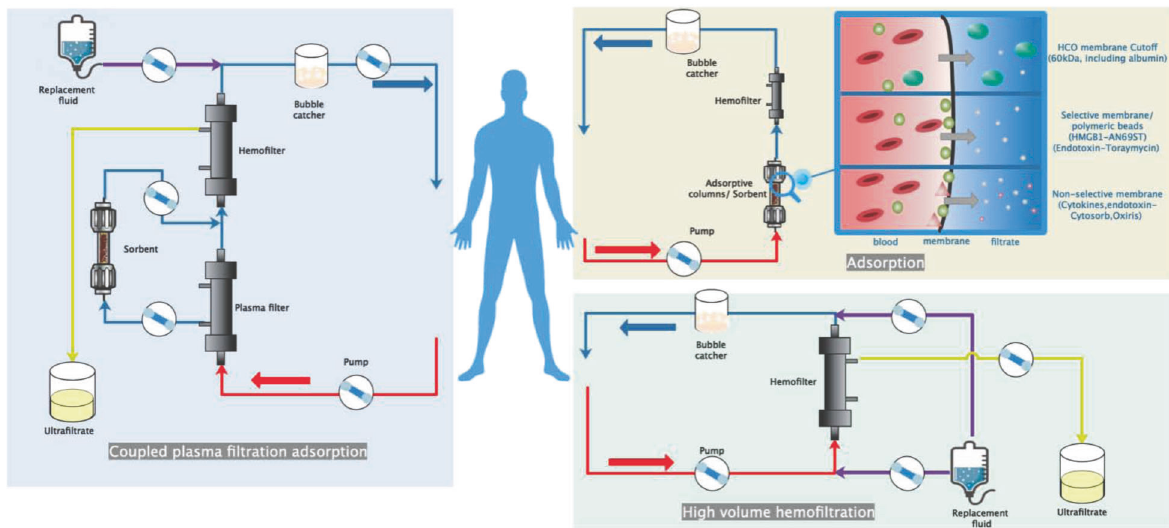
Fig. 4 Schematic diagram of different types of extracorporeal blood-puri fi cation strategies (removal of mediators). Red line = arterial line, blue line = venous line, yellow line = ultra fi ltrate, purple line = replacement fl